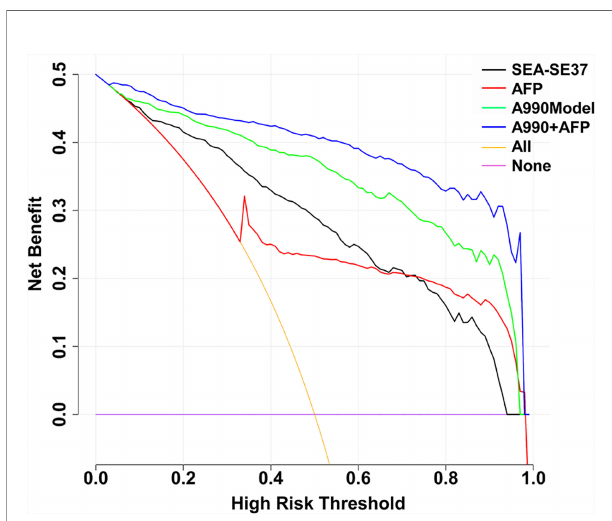
FIGURE 6 | Decision curves of the aptamer-based triple serum fl uorescence intensity indicators alone and in combination. SEA-SEA37: the difference in fl uorescence intensity at 37°C between the serum that was incubated with EvaGreen and aptamer and the serum that reacted with EvaGreen. AFP: alpha- fetoprotein. A990Model: the diagnostic model established by the combination of triple serum fl uorescence indicators (six original) of aptamer AP-HCS-9-90. A990+AFP: diagnostic model established by the combination of triple serum fl uorescence indicators (six original) of aptamer AP-HCS-9-90 and AFP.